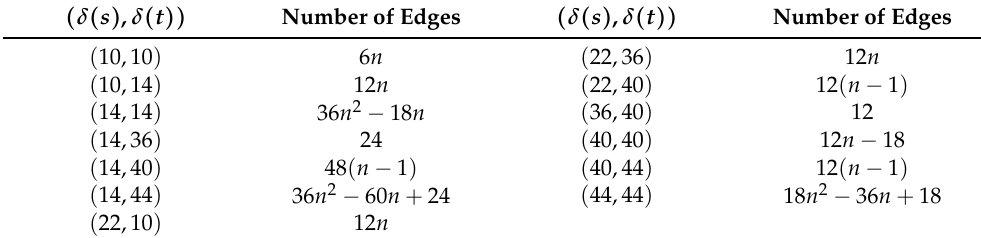
Table 2. Edge partition based on sum of degrees for BPOH ( n )